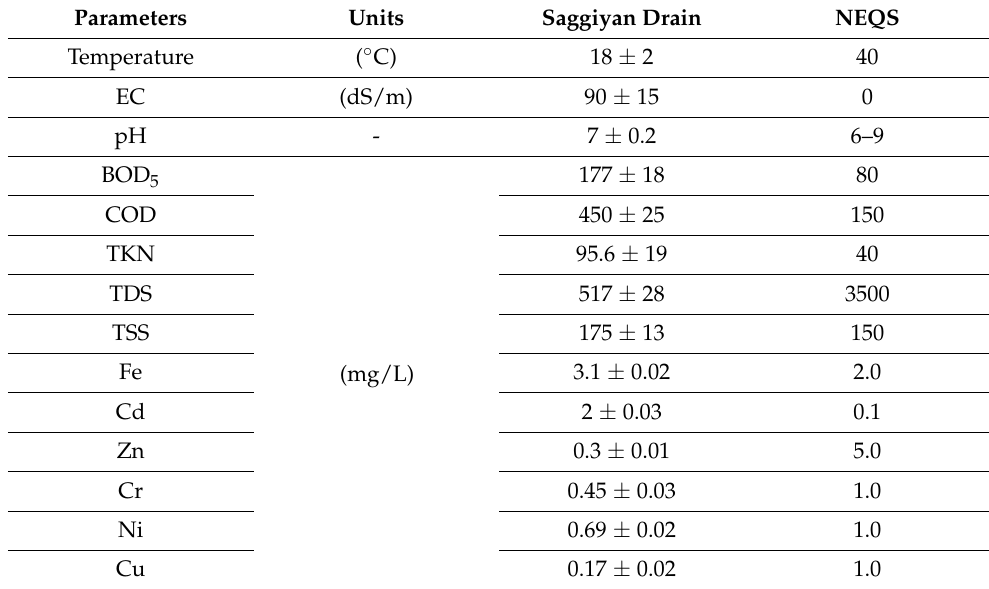
Table 1. Characterization results of Saggiyan drain wastewater.